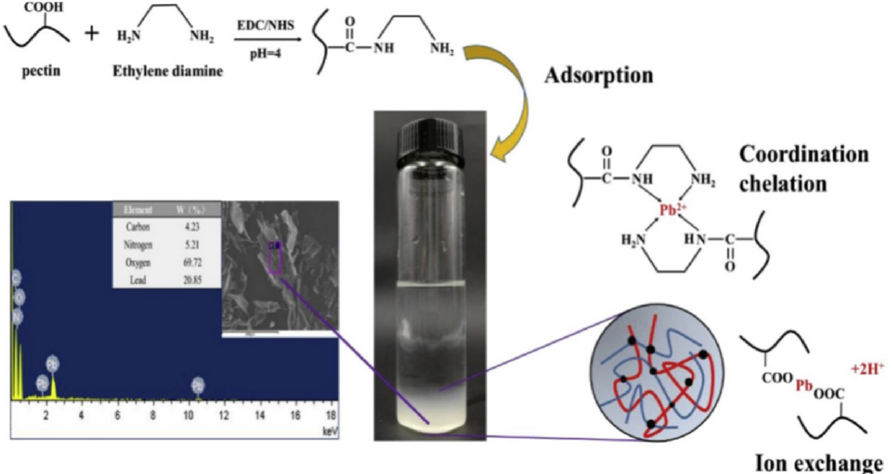
Figure 7. The process of ethylenediamine-modified pectin preparation and its adsorption mechanism for Pb 2+ [177].